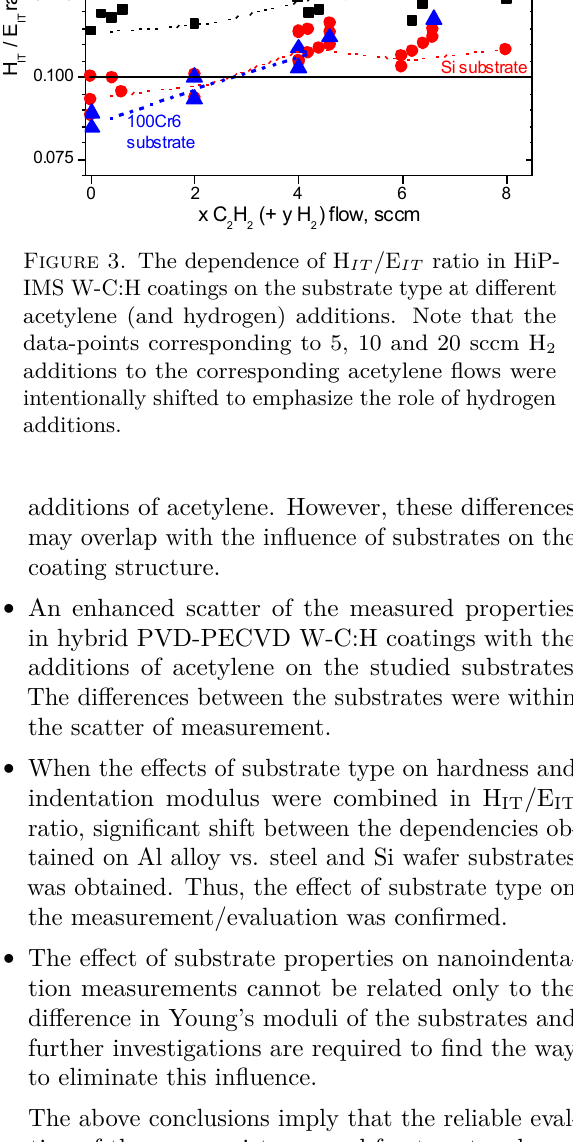
/E ratio in HiP- IT IT 2